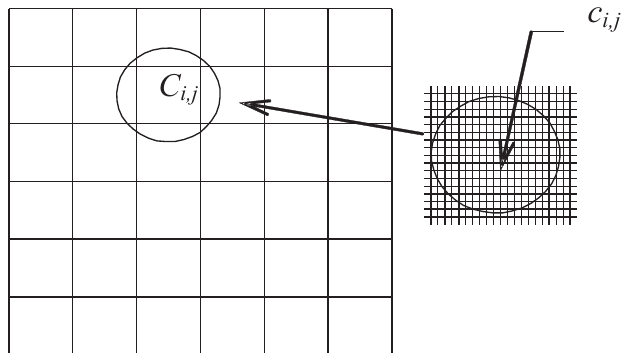
Figure 1. Permeability tensor on each fine-scale cell c i , j upscaled over each coarse-scale cell C i , j